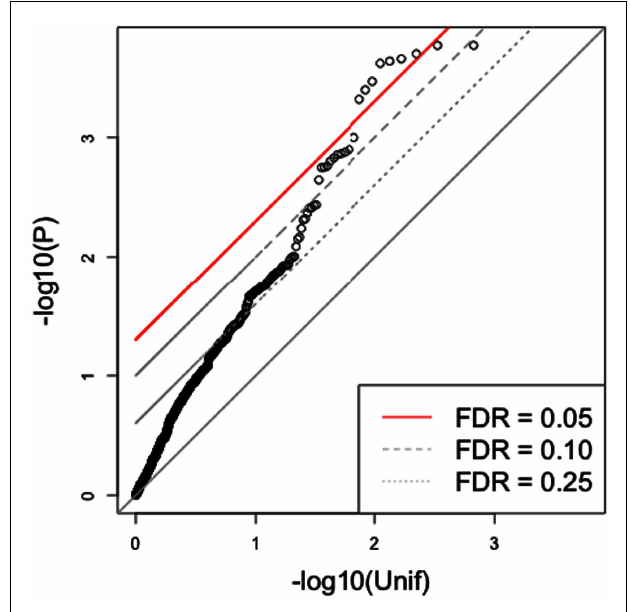
FIGURE 3 |Traditional FDR applied to the triangle method for simulated data. The triangle method may yield numerous highly significant SNP associations, based on the traditional FDR approach, from a simulated phenotype. In this case, several significant SNPs are obtained from simulated data although none should be observed.